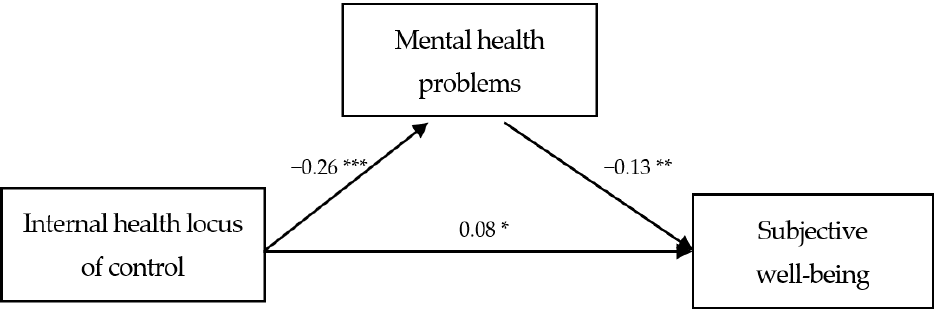
Figure 1. Study model. * p < 0.05 ; ** p < 0.01 ; *** p < 0.001